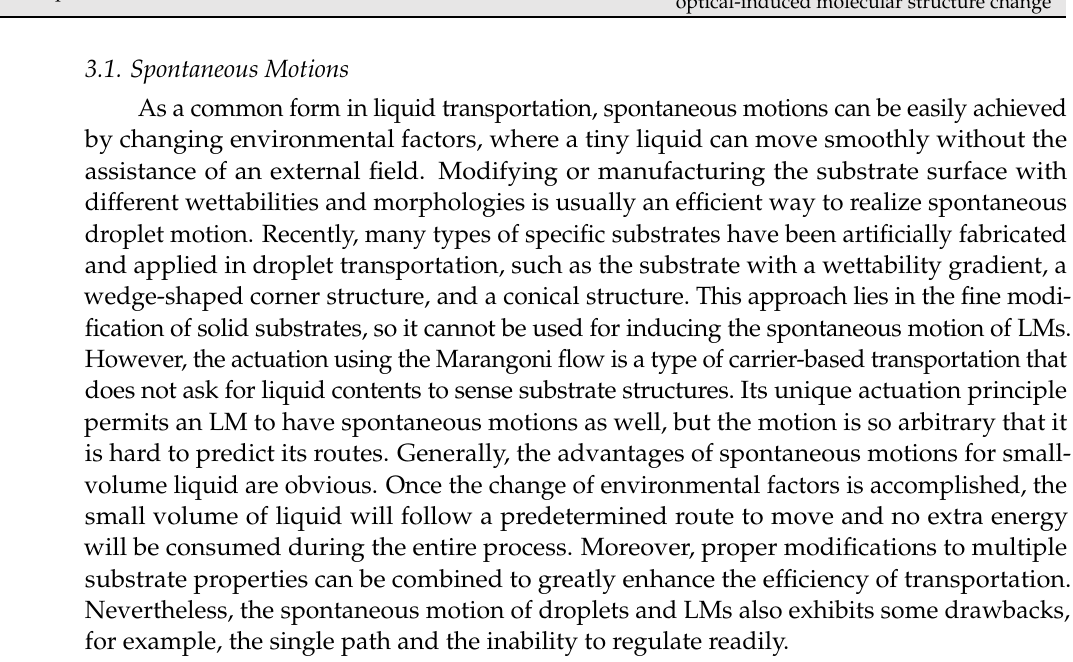
”and “ (cid:125) ” symbolize (cid:35)